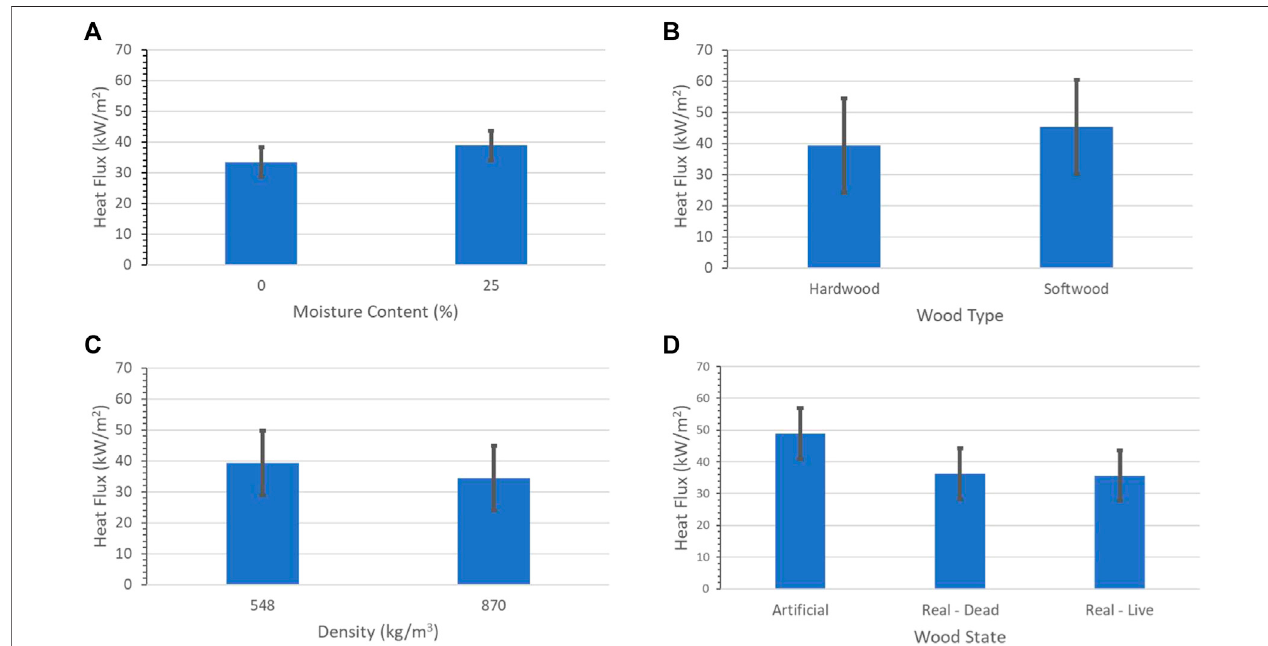
FIGURE 8 | Results from the experimental designs to evaluate the impact of single factors (A) moisture content, (B) wood type, (C) wood density, and (D) wood state. Error bars correspond to 95% con fi dence intervals.